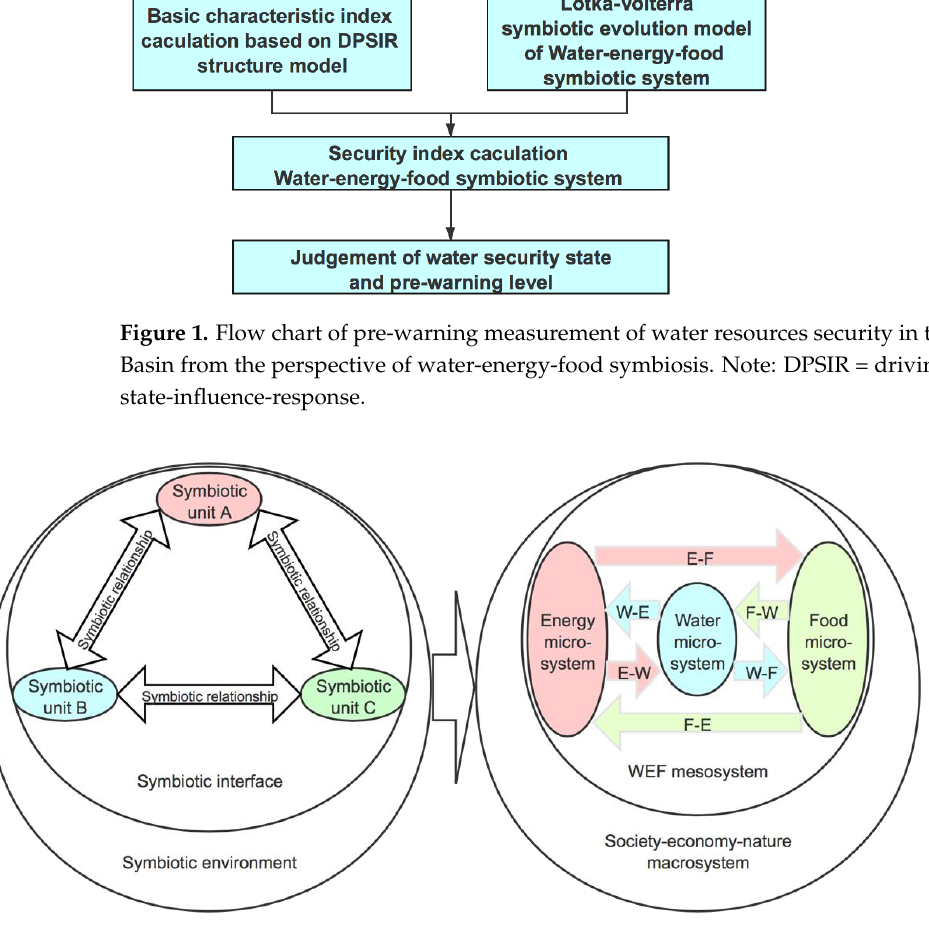
Figure 2. Water-energy-food symbiosis system framework. Note: the WEF in the picture is the abbreviation of water-energy-food, W-E means that water acts on energy, E-W means that energy acts on water, W-F means that water acts on food, F-W means that food acts on water, E-F means that energy acts on food, F-E means that food acts on energy.